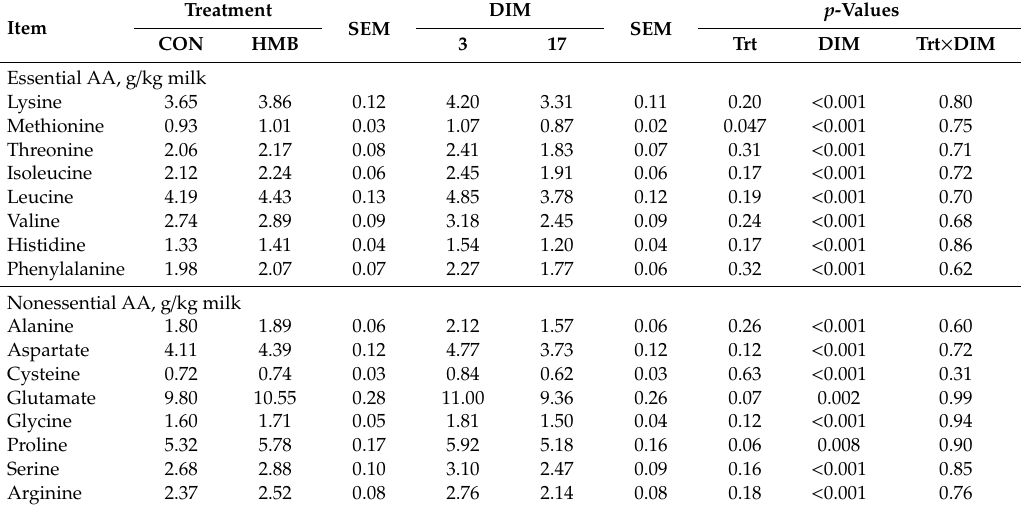
Table 2. Milk amino acids compositions of control (CON) and HMB-supplemented (HMB) sows during early and peak lactation. Item Essential AA, g / kg milk